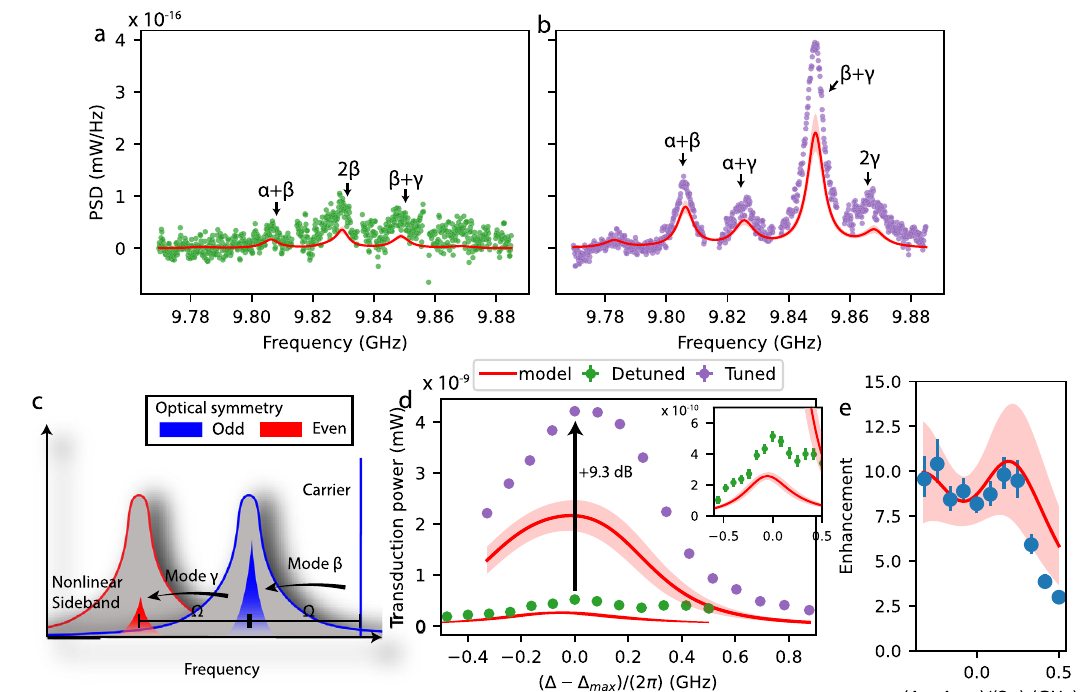
Fig. 5 | Enhanced nonlinear transduction. In panels a and b , we compare the optimalnonlinearpartofthepowerspectraldensity(PSD)fordetuned( a )totuned ( b ) modes. PSD was normalised to per cavity photon. The red line is the indepen- dent model prediction, the shaded region is the estimated uncertainty on the model.Thedetuning(powerused)was5.15GHz(69 μ W)and7.52GHz(152 μ W)for ( a ) and ( b ), respectively. c A schematic representation of the optimal resonance conditionforscatteringfrommode β andthenmode γ . d The fi ttedareaofthe β + γ tone for detuned and tuned modes while varying Δ around the optimal point. The inset is a zoom-in of the detuned cavity data. Vertical error bars are standard